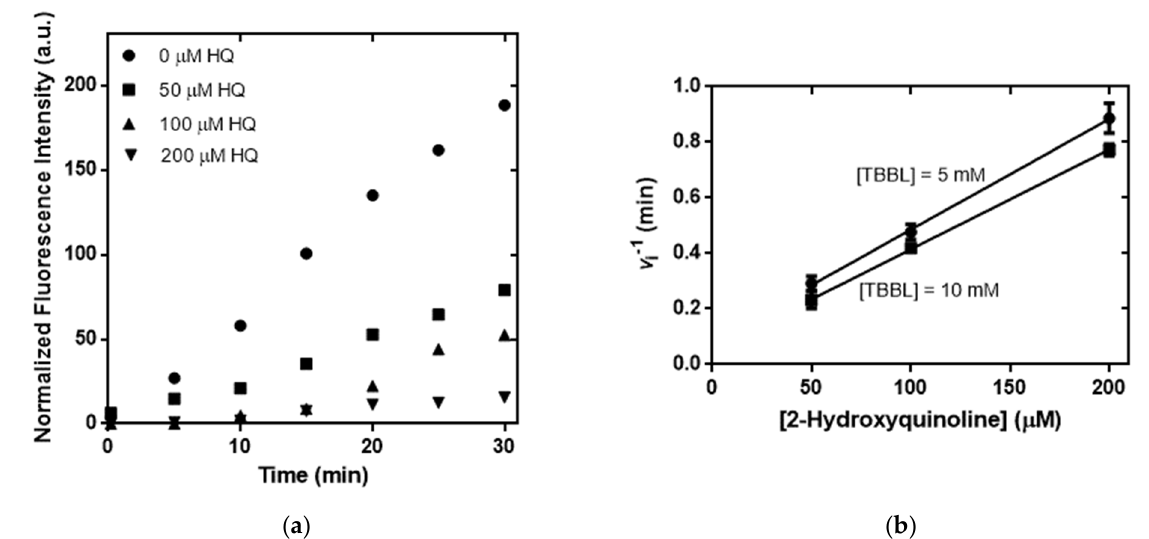
Figure 6. 2-Hydroxyquinoline (HQ) inhibition of PON1 catalysis analyzed by the fluorescence assay based on 16b . ( a ) Time-course kinetic analysis of HQ inhibition of PON1 (250.9 U L − 1 , 1.25% glycerol) catalysis was performed in the presence of TBBL (5 mM in ACN, 1%) in the Tris buffer. Each PON1 reaction contained 0, 50, 100 or 200 µ M of HQ (in 1% ACN). ( b ) Dixon plot of the inhibitory kinetics of HQ on PON1 catalysis was derived from the v i in ( a ) and Figure S5. The HQ inhibitor constant K i was determined from the minus x-axis value at which the two extrapolated lines intersected, which, in this study, was 20.9 µ M. Please see Section 3.4 for the experimental details. Each reaction was analyzed at least three times in order to acquire the averaged values and standard deviation (the error bar) of v i .